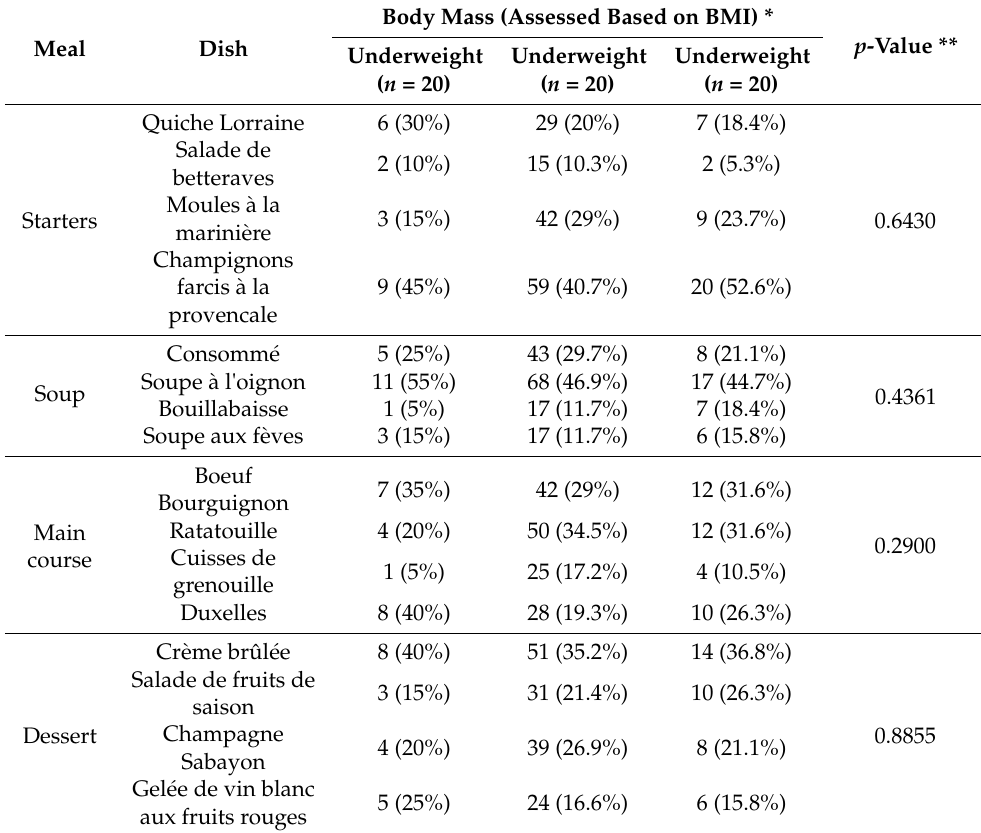
Table 10. The dish choices from the model French restaurant menu, stratified by body mass, in the studied sample of young Polish